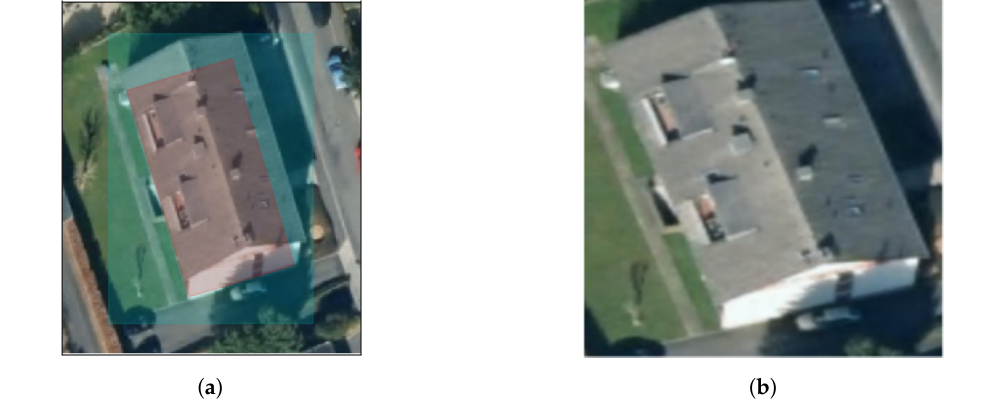
Figure 5. ( a ) Witten building outline in red shading overlaid on the satellite image. The enlarged crop area is shown in cyan shading. ( b ) The final generated image,